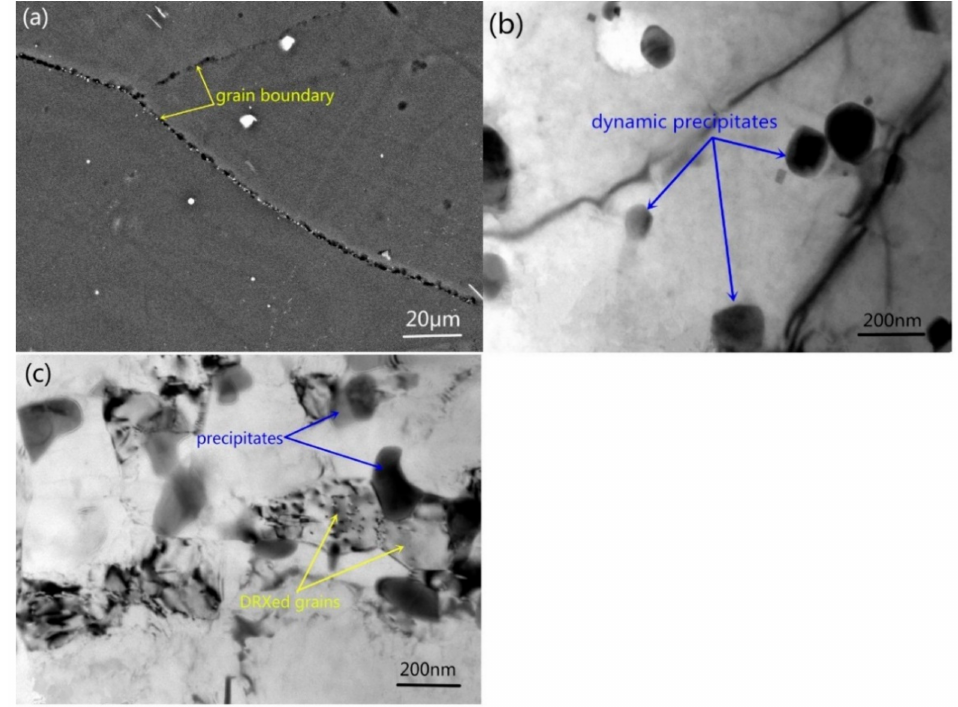
Figure 11. ( a ) BSE and ( b ) TEM images of the samples deformed to ε = 0.1, ( c ) TEM images of the